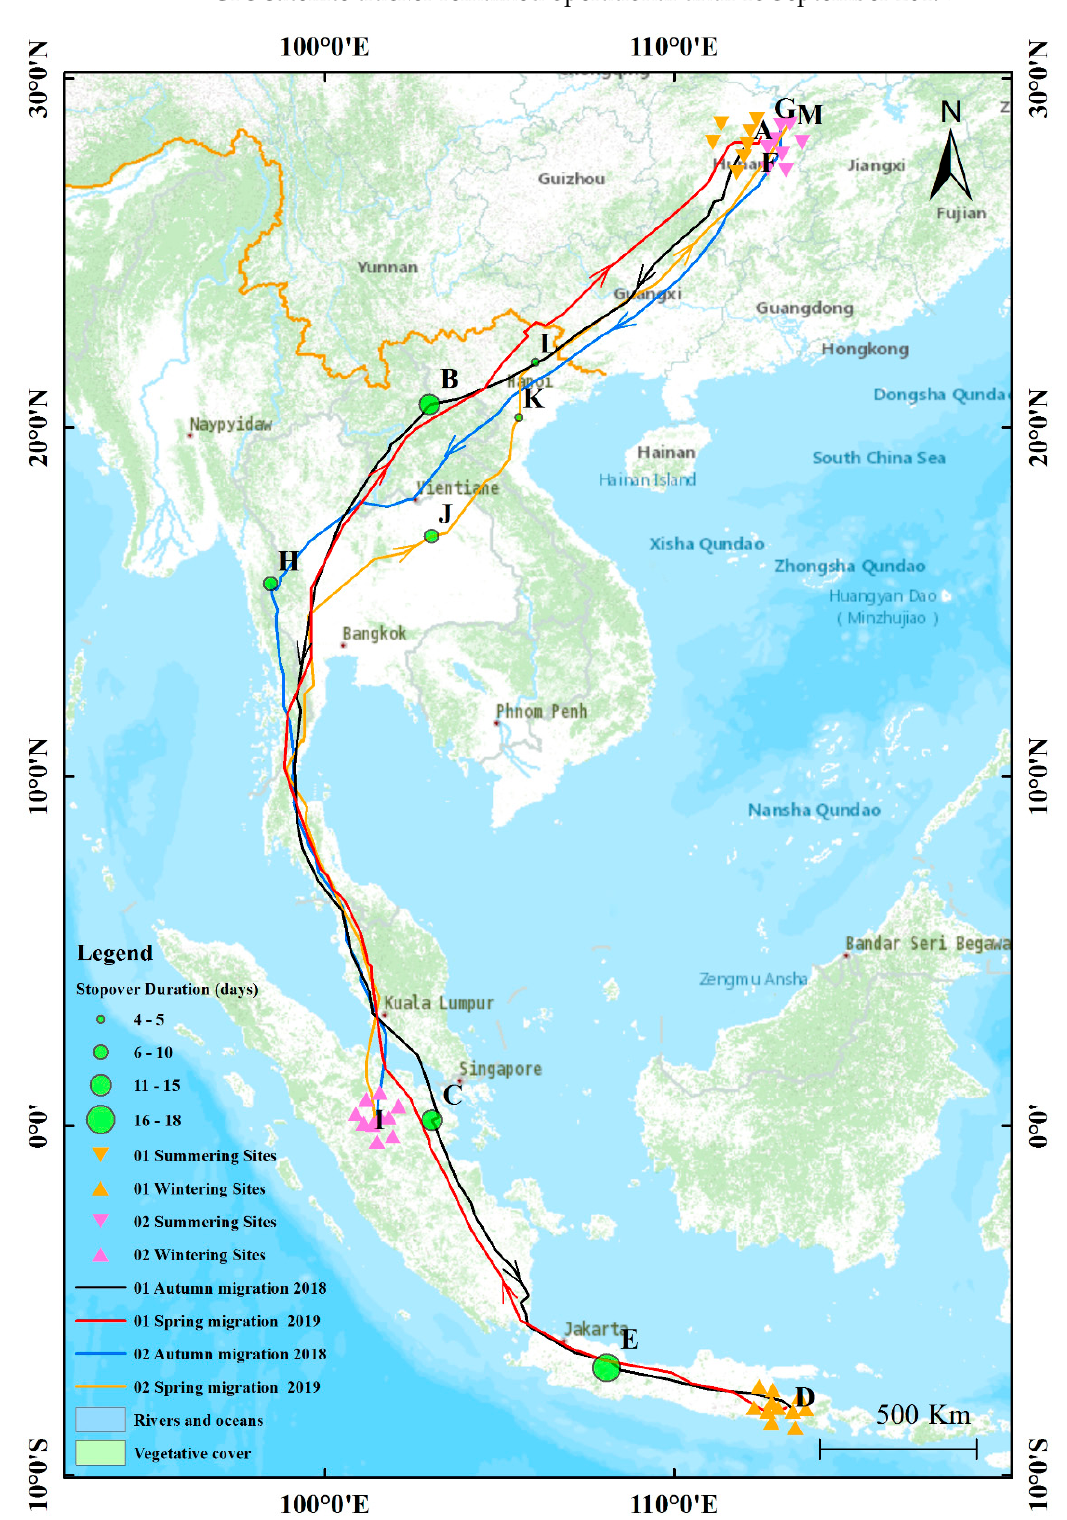
Figure 1. Migration routes and main sites used by individual Chinese Sparrowhawks linked by solid lines. Green circles indicate stop-over sites. Summering sites: A, F, G, M; Wintering sites: D, I; Stop-over sites: B, C, E, H, J, K, L.